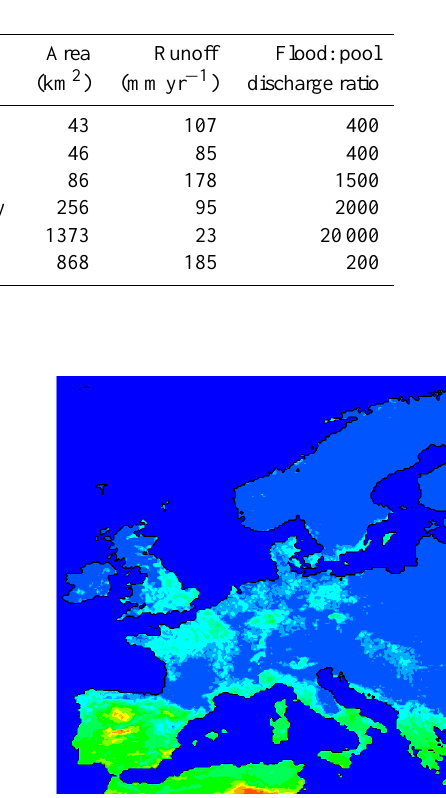
Table 2. Ratios of flood to pool discharges reported for some MIRAGE catchments for which these levels have been observed.